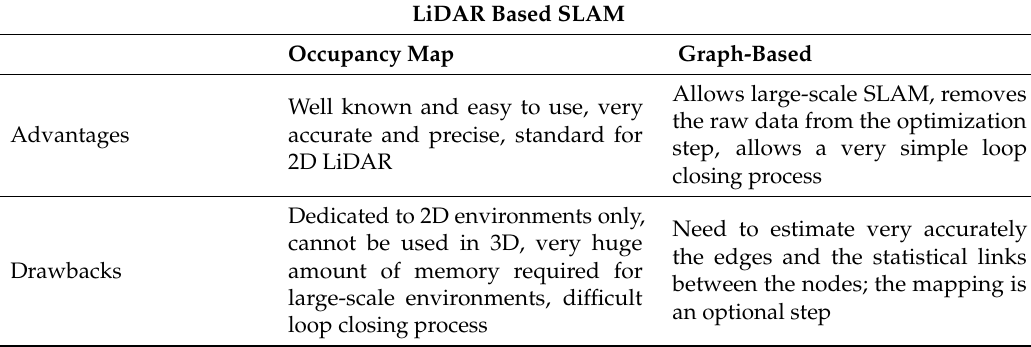
Table 2. Summary of LiDAR based SLAM’s advantages and